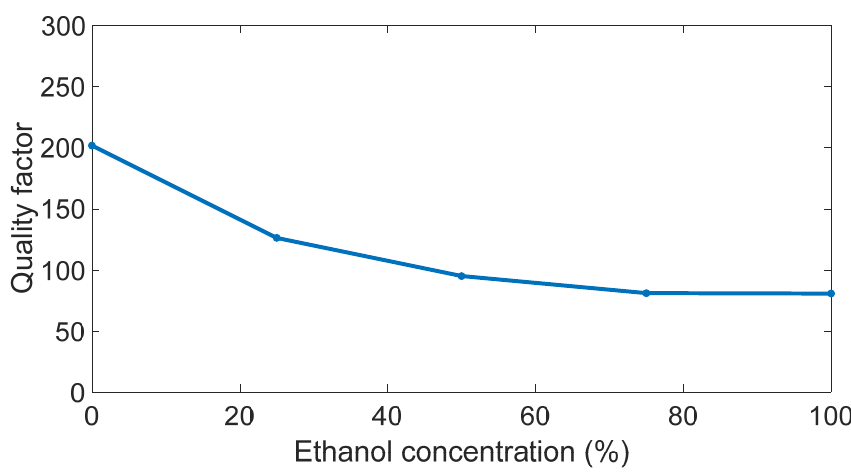
Figure 8. Antenna quality factor versus ethanol concentration.